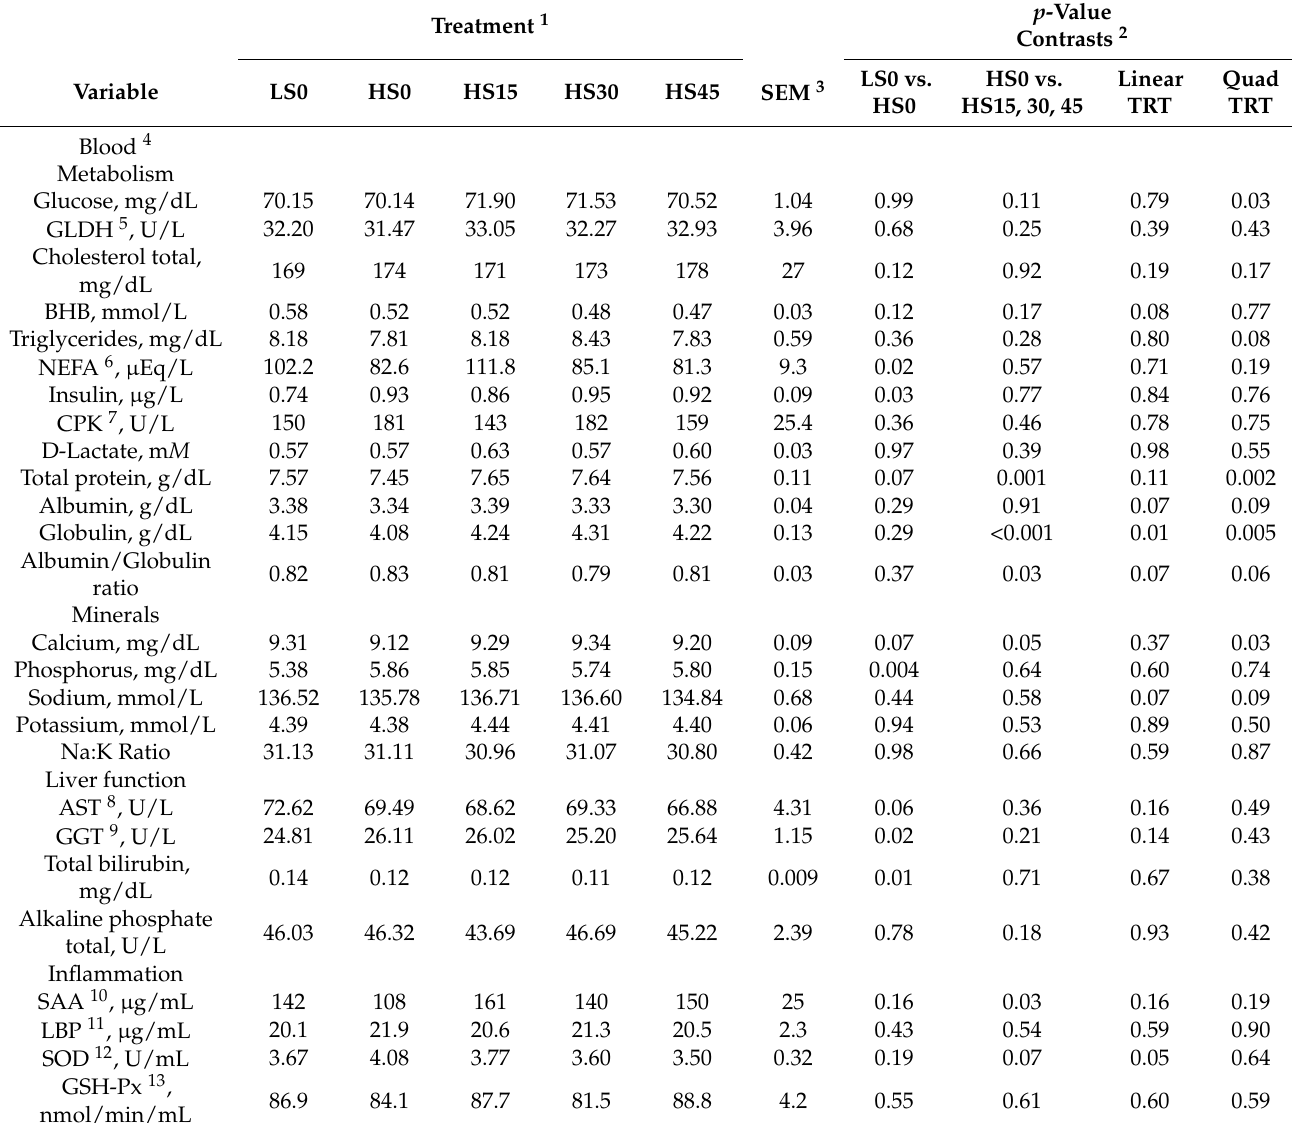
Table 6. Least squares means and associated SEM for blood metabolites of Holstein cows in low-starch diets without autolyzed yeast products (LS0), high-starch diets without autolyzed yeast products (HS0), HS with 15 g (HS15), 30 g (HS30), and 45 g (HS45) of autolyzed yeast during the experimental period. Samples were collected on d 15, 18, and 21 during the last week of each